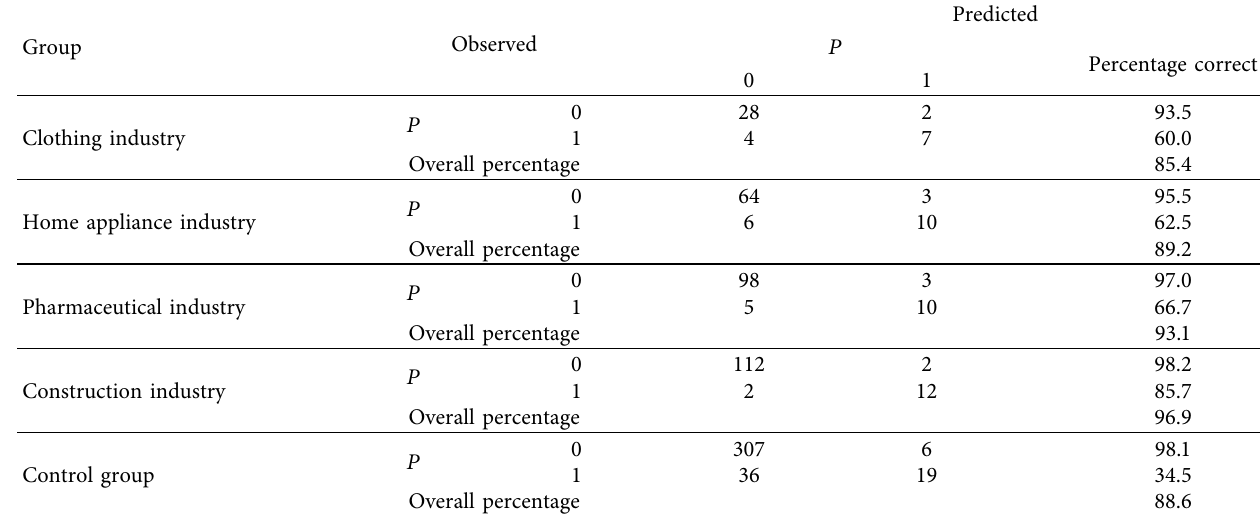
Table 14: Classifcation